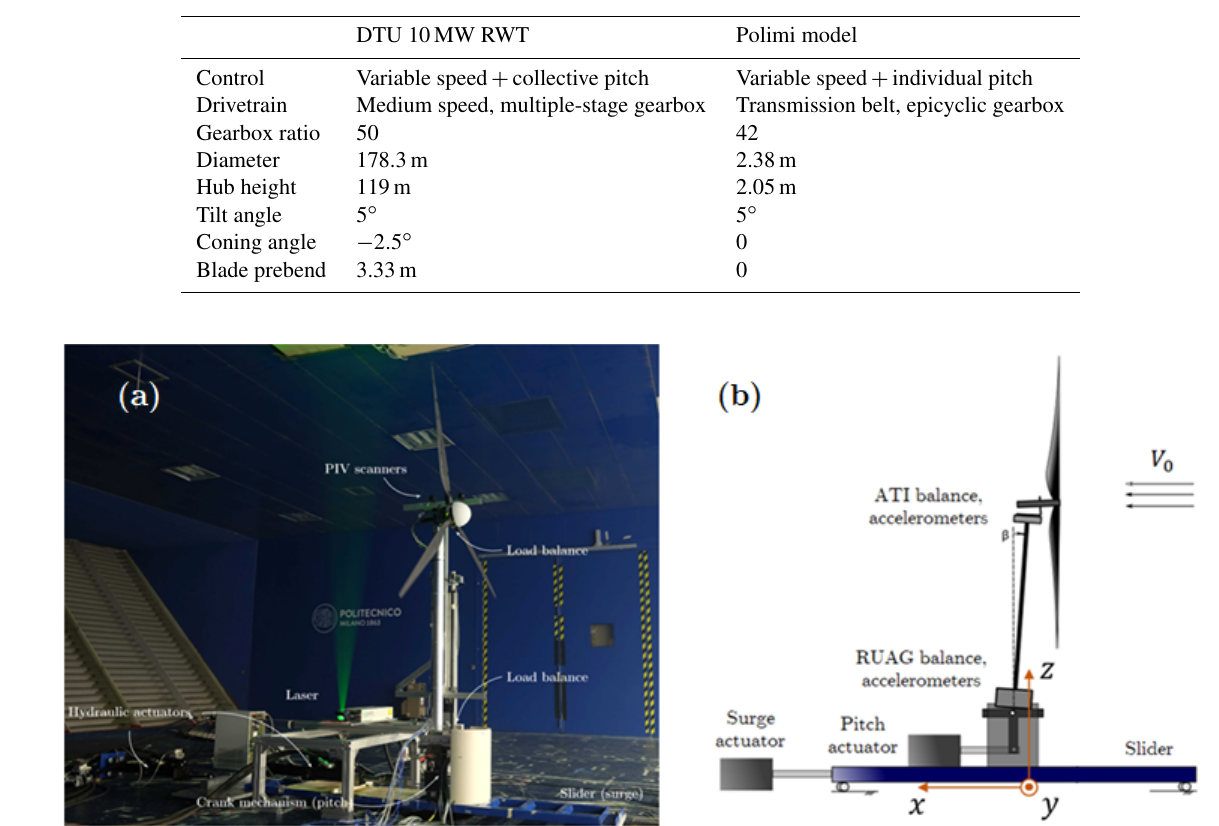
Figure 3. Experimental set-up picture (a) and schematic sketch with the reference system (b)